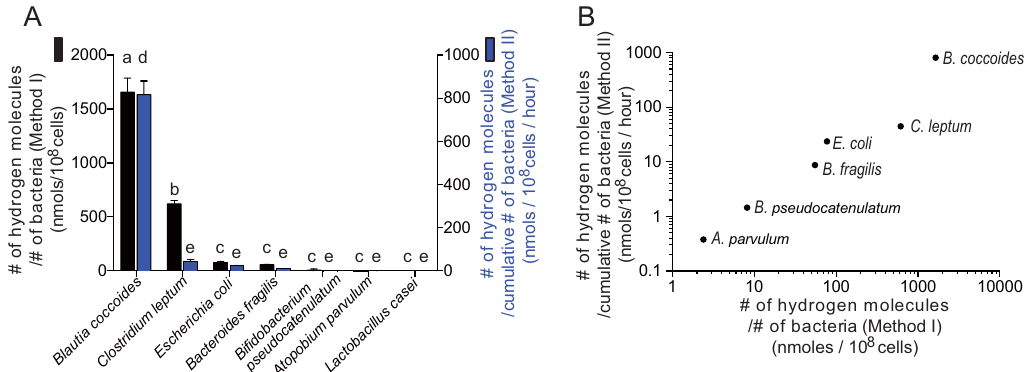
Fig 2. The amount of hydrogen production by seven intestinal bacteria. The amount of hydrogen production was normalized in two ways. Black bars represent the hydrogen production normalized by the number of bacteria at the transition between the growth and stationary phases (arrows in Fig 1) (Method I). Blue bars represent the hydrogen production normalized by the cumulative number of bacteria from time zero to the transition between the growth and stationary phases (arrows in Fig 1) (Method II). The normalized hydrogen productions are indicated in a bar graph on a linear scale (A) and in a scattered plot on a logarithmic scale (B) . (A) Mean and SD are indicated ( n = 3 or 4 culture tubes). P values by one-way ANOVA are < 0.0001 for both Methods I and II. Different symbols in Methods I (a, b, and c) and II (d and e) indicate p < 0.05 by Tukey-Kramer posthoc test. (B) The Pearson’s correlation coefficient between Methods I and II is 0.950 ( p = 0.001). Note that Lactobacillus is not plotted because the hydrogen production was not